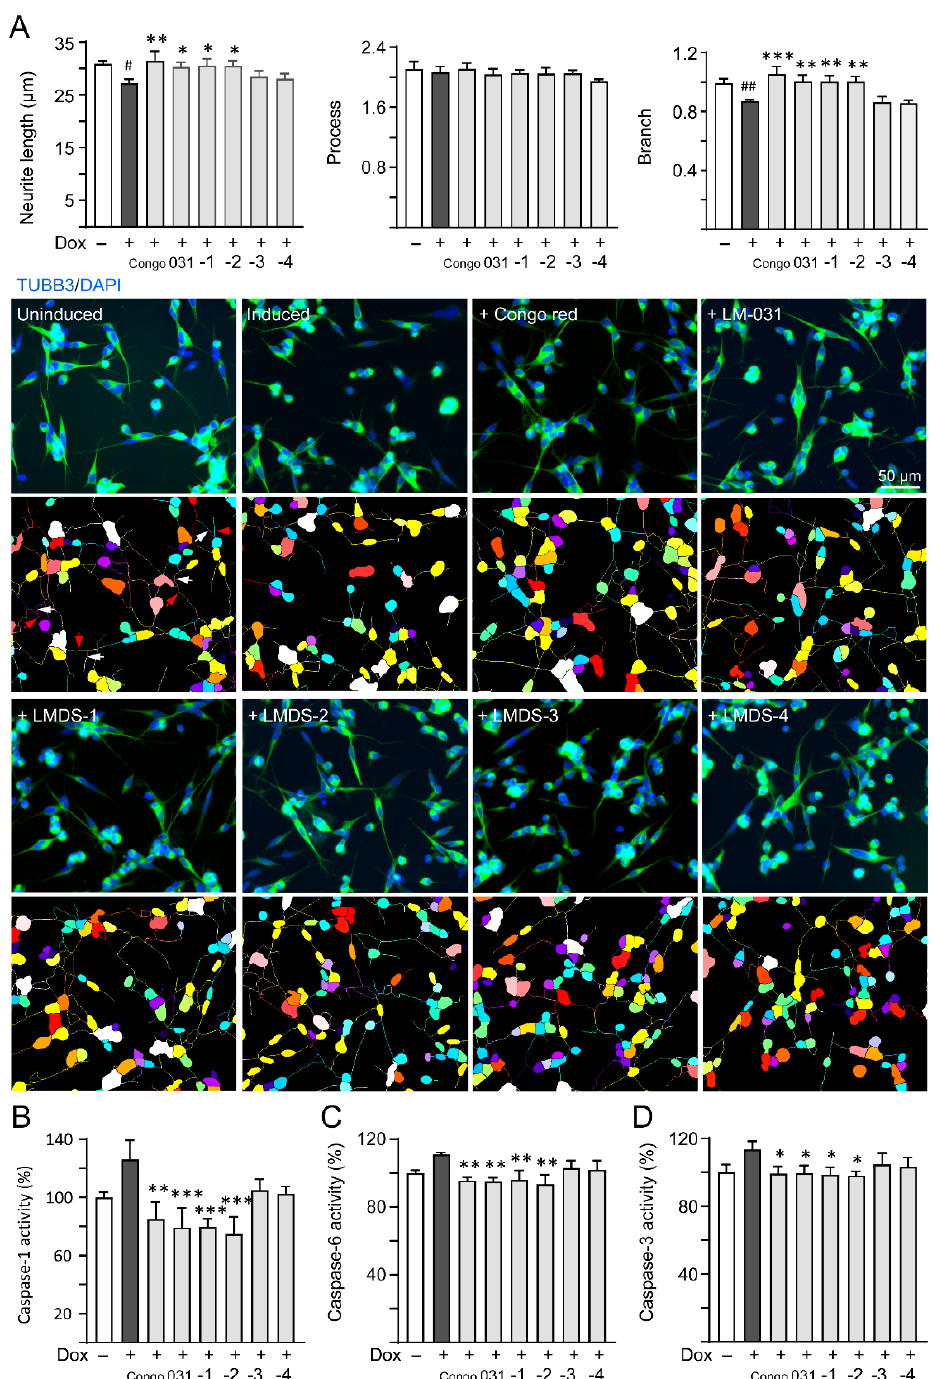
Figure 3. Neuroprotective effects of LM-031 and LMDS-1 to -4 in ∆ K280 tau RD -DsRed SH-SY5Y cells. ( A ) Neurite outgrowth (length, processes and branching) assay of ΔK280 tau RD -DsRed cells unin- duced, untreated or treated with Congo red, LM-031 or LMDS-1 to -4 at 10 µM ( n = 3). Shown below are images of TUBB3 (green)-stained cells with nuclei being counterstained with DAPI (blue), and segmented images with multi-colored mask to assign the outgrowth of a cell body for quantification. In uninduced cells, processes and branches are indicated with red and white arrows, respectively. ( B ) Caspase-1, ( C ) caspase-6 and ( D ) caspase-3 activity assays with Congo red, LM-031 or LMDS-1 to -4 (10 µM) treatment ( n = 3). The relative caspase-1/caspase-6/caspase-3 activity of uninduced cells (Dox − ) was normalized (100%). p values: comparisons between induced (Dox+) vs. uninduced (Dox − ) cells ( # : p < 0.05, ## : p < 0.01), or compound-treated vs. untreated (induced) (Dox+) cells (*: p < 0.05, **: p < 0.01, ***: p < 0.001) (one-way ANOVA with a post hoc Tukey test).